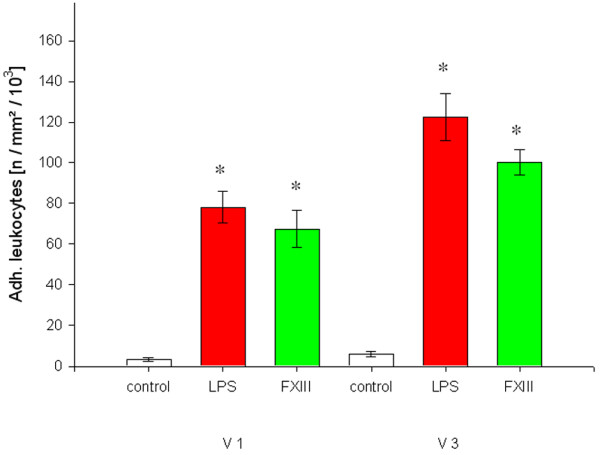
Effects of factor XIII administration on intestinal leukocyte adherence in the submucosal layer during experimental endotoxemia. Adherent (Adh) leukocytes in V1-/V3-venules after two hours of endotoxemia (mean ± standard error of the mean; *p < 0.05 compared to control group; p > 0.05 lipopolysaccharide (LPS) plus F XIII group compared to LPS group). Control, control group; F XIII, factor XIII treated LPS group; LPS, untreated LPS group.